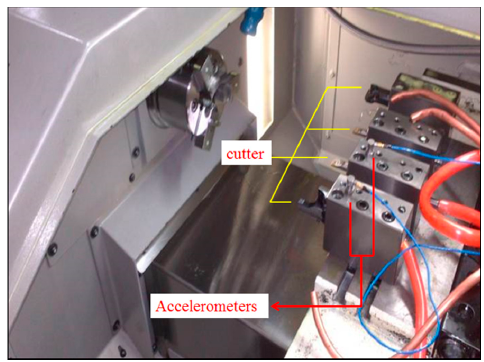
Figure 2. Setup of cutter and accelerometers.